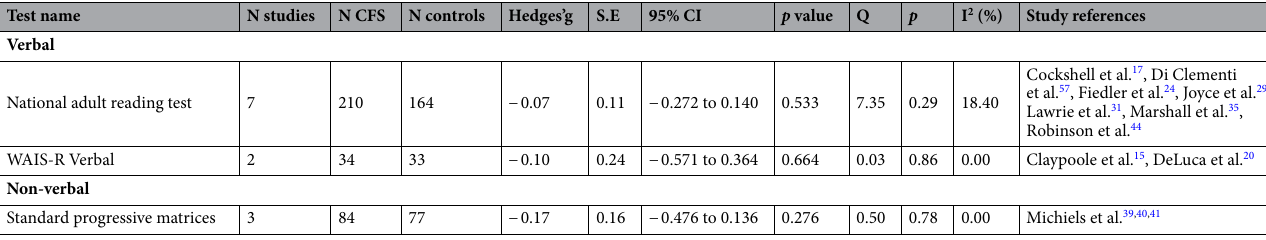
Table 2. Intellectual efficiency: Hedge’s g effect sizes for each test, in descending order. WAIS Wechsler adult intelligence scale, ME/CFS myalgic encephalomyelitis/chronic fatigue syndrome, N number.